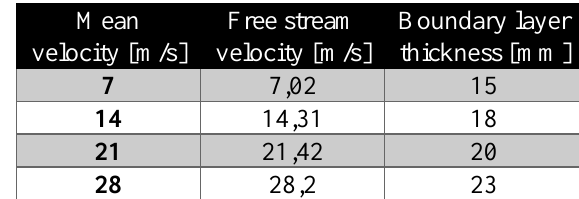
Table 2. Boundary layer thickness